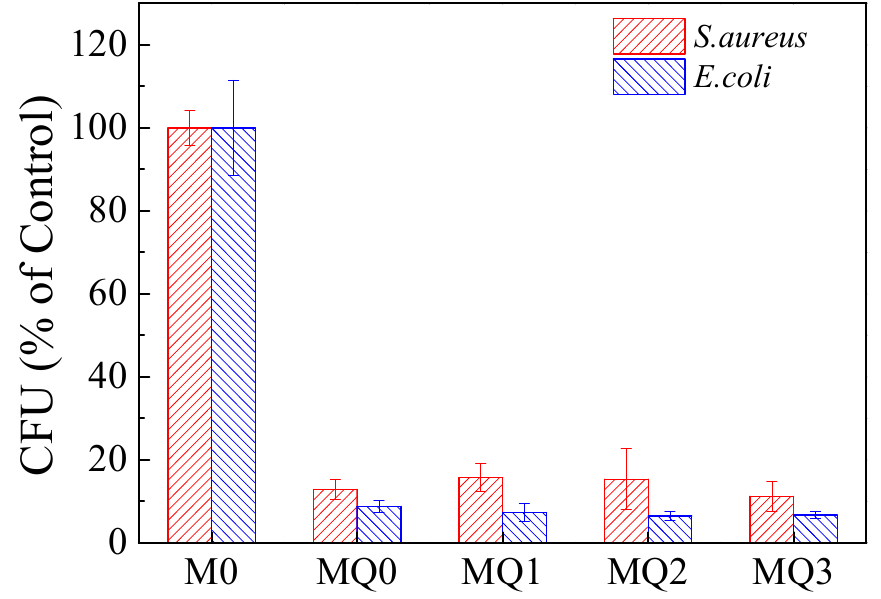
Figure 9. CFU (percentage of control) on M0 and MQ relative to that on M0 suffered from three fouling–cleaning cycles. A cycle includes exposure to bacterial suspension for 3 h followed by 2 h cleaning by 0.5 vol.‰ NaClO. The 0, 1st, 2nd and 3rd fouling–cleaning cycle is denoted as MQ-0, MQ-1, MQ-2 and MQ-3, respectively ( n = 3).